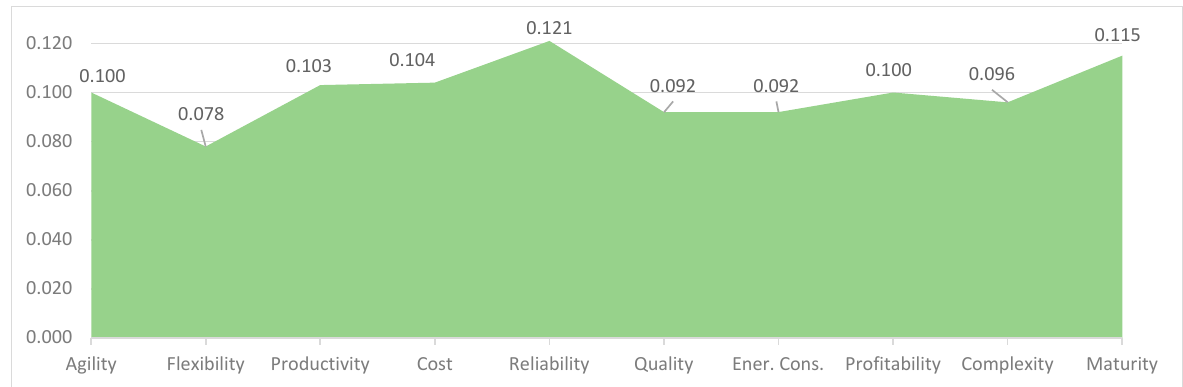
Figure 5. Criteria weighting results.